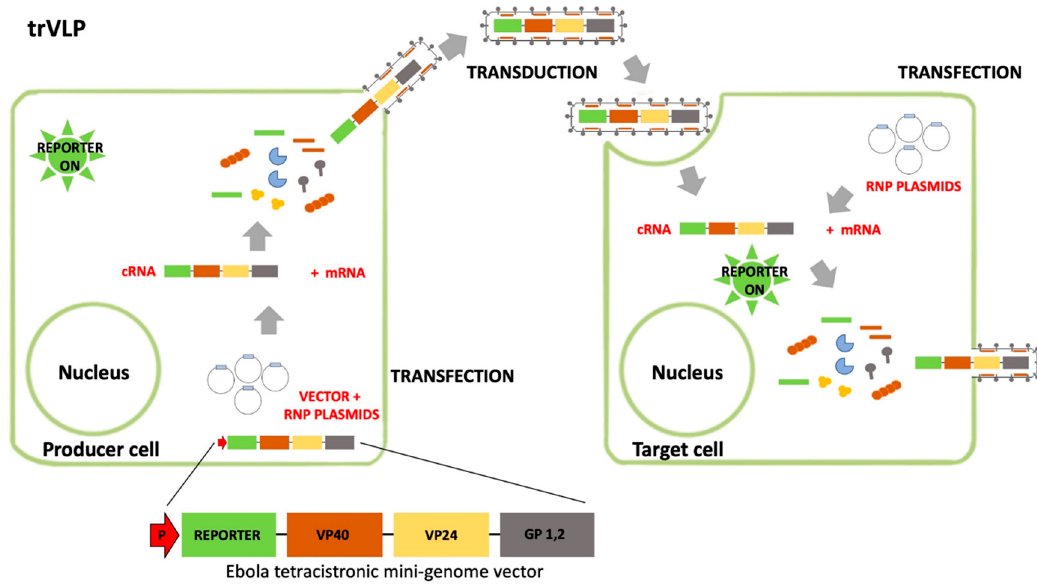
Figure 4. Transcription- and replication-competent eVLP (tr-eVLP). This system is based on a minigenome, encoding for a reporter gene, the viral proteins VP40, GP, and in some cases p24, co-transfected with the constructs expressing RNP proteins (N, VP35, VP30, and L). Inside the producer cells, VP40 drives the formation of eVLPs that harbor minigenome-containing nucleocapsids. These tr-eVLPs can transduce target cells and deliver the minigenome that undergoes primary transcription mediated by RNP proteins brought into the target cells within the tr-eVLPs (in the form of nucleocapsids), resulting into the expression of the reporter gene. If target cells are pre-transfected with plasmids encoding for RNPs, the minigenome is replicated and undergoes a secondary transcription (with the expression of the reporter gene) mediated by RNP proteins provided in trans from expression constructs. Furthermore, a new progeny of infectious tr-eVLPs is produced and can be used to transduce new target cells.